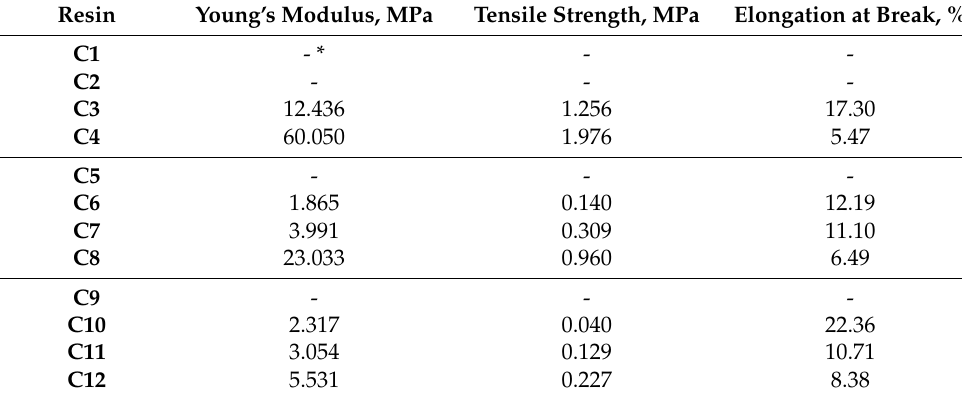
Table 4. Mechanical characteristics of the polymers obtained by the tensile